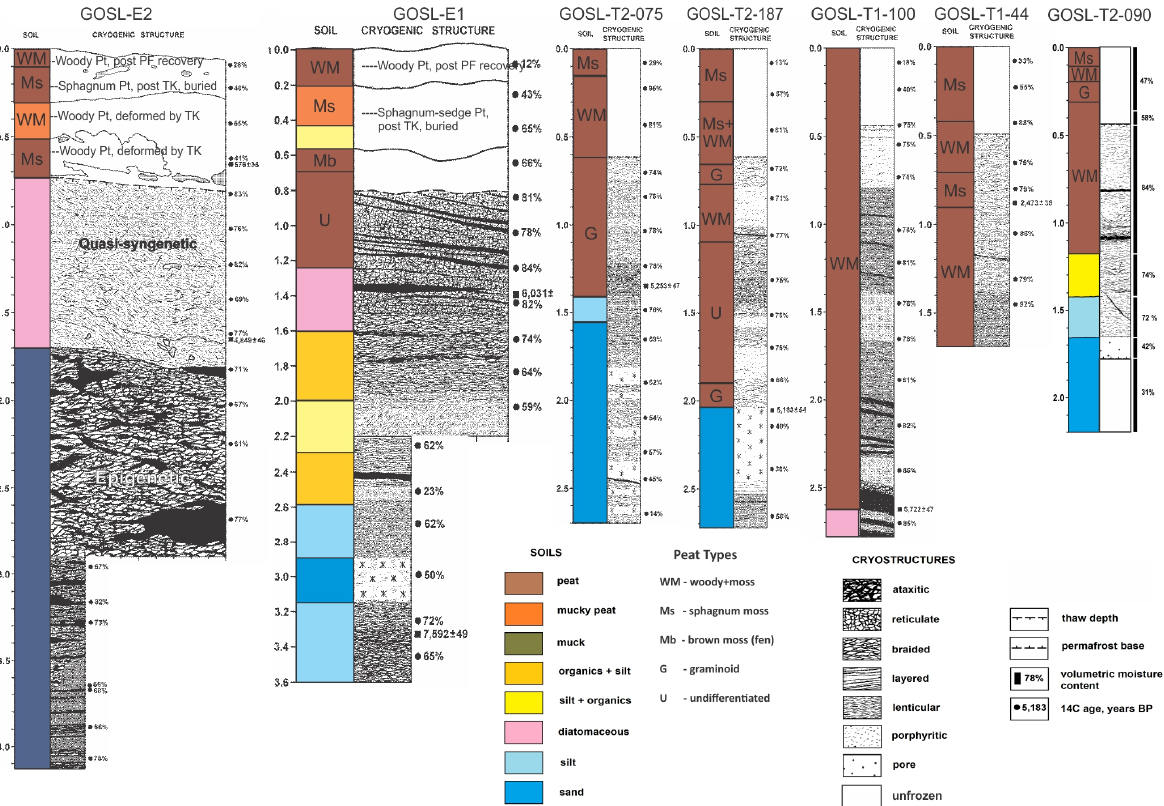
Figure 10. Soil stratigraphy of two bank exposures ( E1 and E2 ) and five cores showing soil texture, peat types, and cryogenic structures at Gosling Lake. The larger exposures illustrate changes in peat types associated with woody peat accumulated after initial permafrost formation and later deformed by thermokarst (TK), Sphagnum accumulated after thermokarst, and woody forest peat accumulated after permafrost recovery. During permafrost recovery, quasisyngenetic permafrost forms where freezing occurs upward during peat accumulation and active layer thinning, and epigenetic permafrost occurs where freezing occurs downward into previously thawed soils.